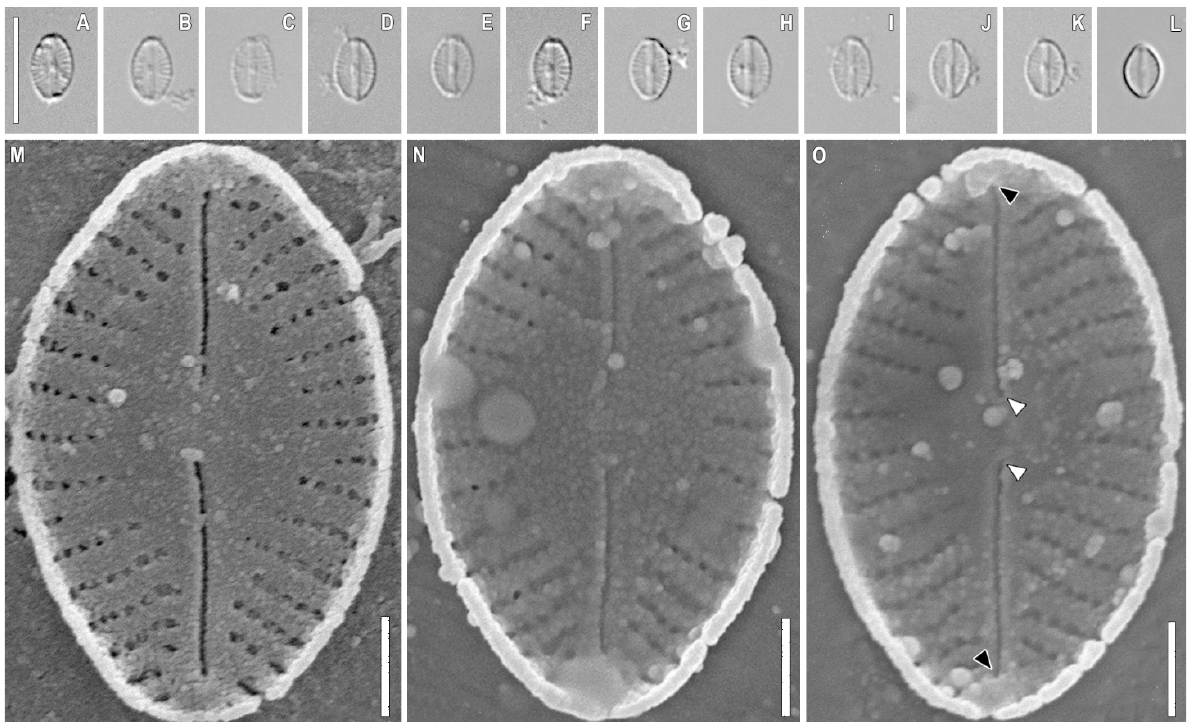
Figure 4. Sellaphora terrestris sp. nov. Strain VP 299. Slide no. 07057. ( A – L ). Light microscopy, differential interference contrast, size diminution series ( M – O ). Scanning electron microscopy, internal views. Black arrowheads show the helictoglossae. White arrowheads show the central raphe ends. Scale bar ( A – L ) = 10 μ m; ( Q ) = 2 μ m; ( M – O ) = 1 μ m.